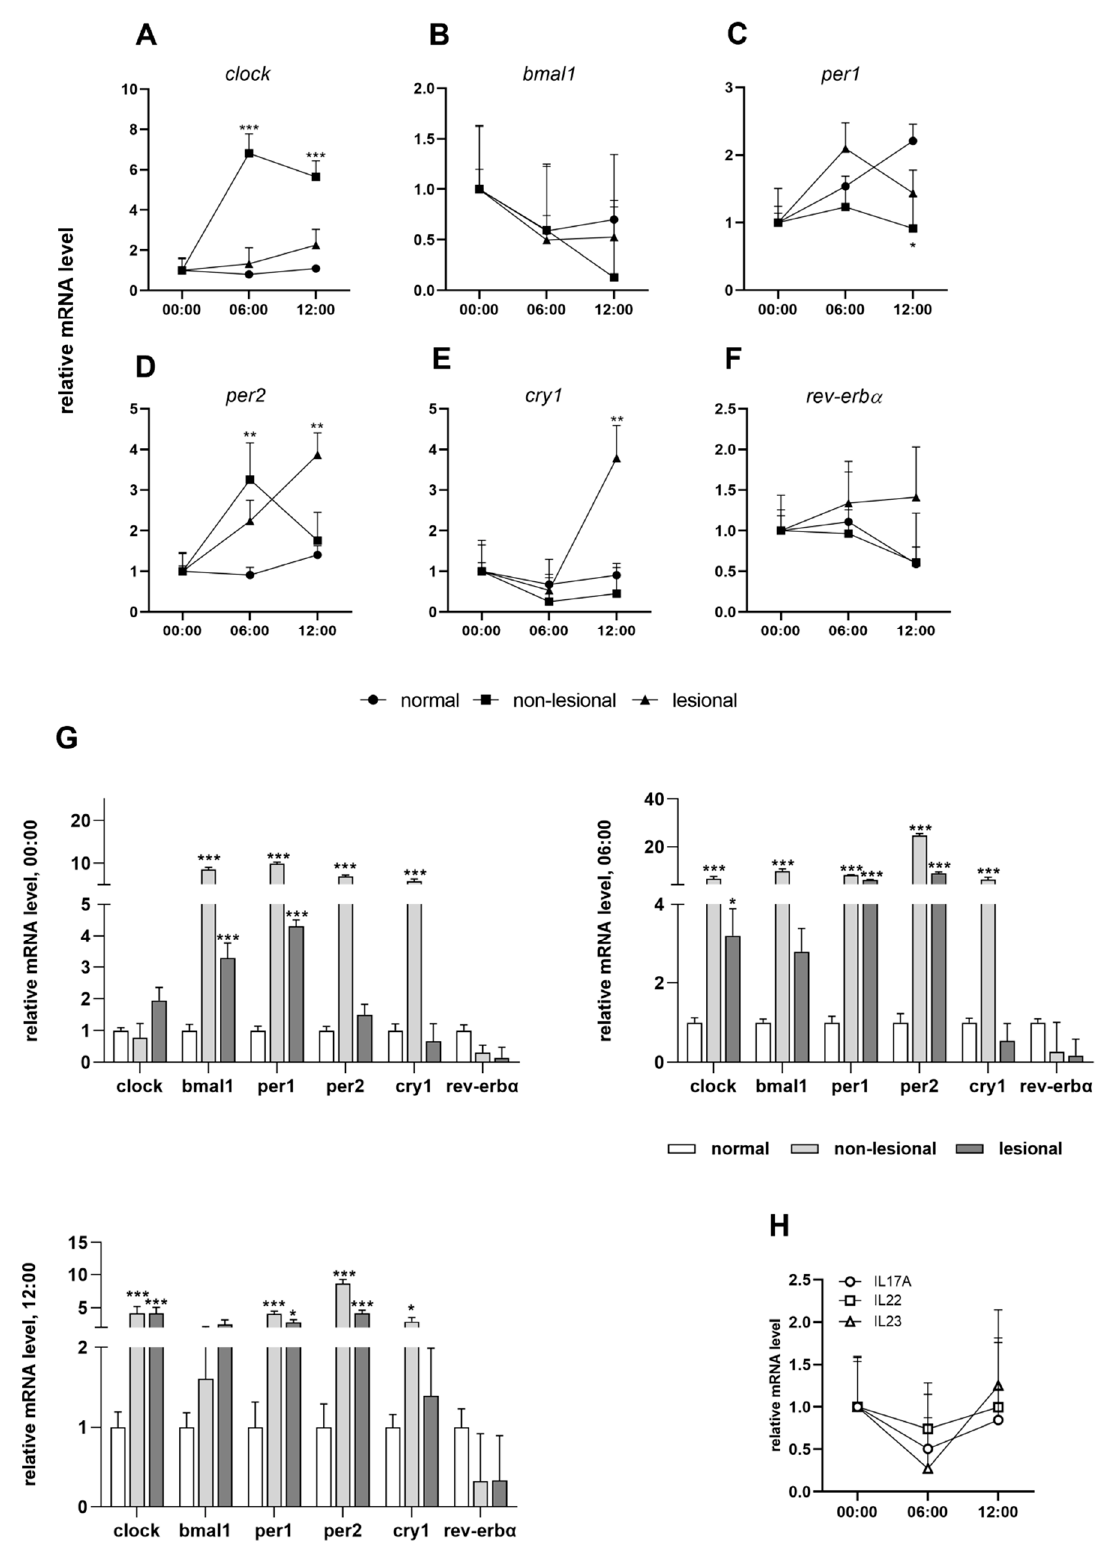
Figure 1. Circadian entrainment in psoriasis: ( A – F ) daily patterns of clock genes in normal, psoriatic non-lesional and lesional skin samples; ( G ) relative mRNA expression levels of the indicated genes at 12:00, 06:00 and at 00:00; ( H ) daily patterns of IL-17A, IL-22 and IL-23 mRNA expression. Significant differences assessed by two-way ANOVA followed by Turkey’s post hoc test between the time points: * p < 0.05; ** p < 0.005; *** p < 0.0005. Data are presented as the means ±